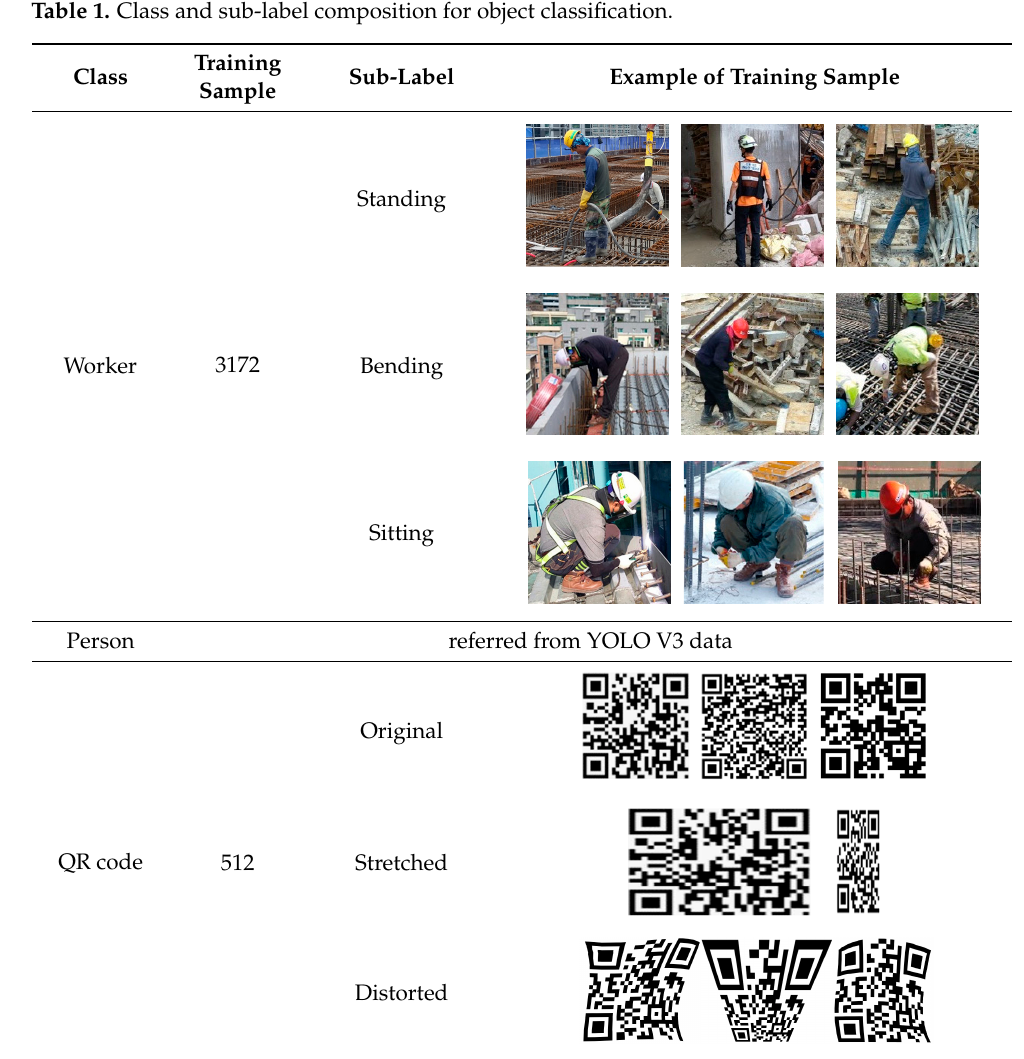
Table 2. Configuration of the training inputs.